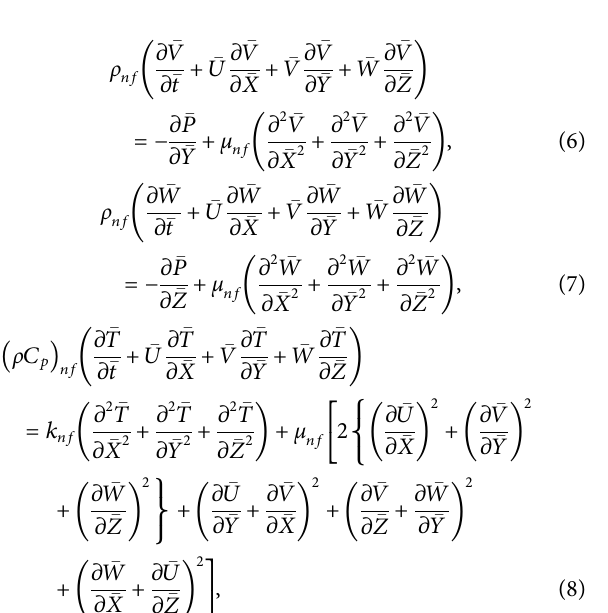
FIGURE 9 | (A) 2D-Temperature plot for Brinkmannumber . (B) 3D-Temperature plot for Brinkman number.